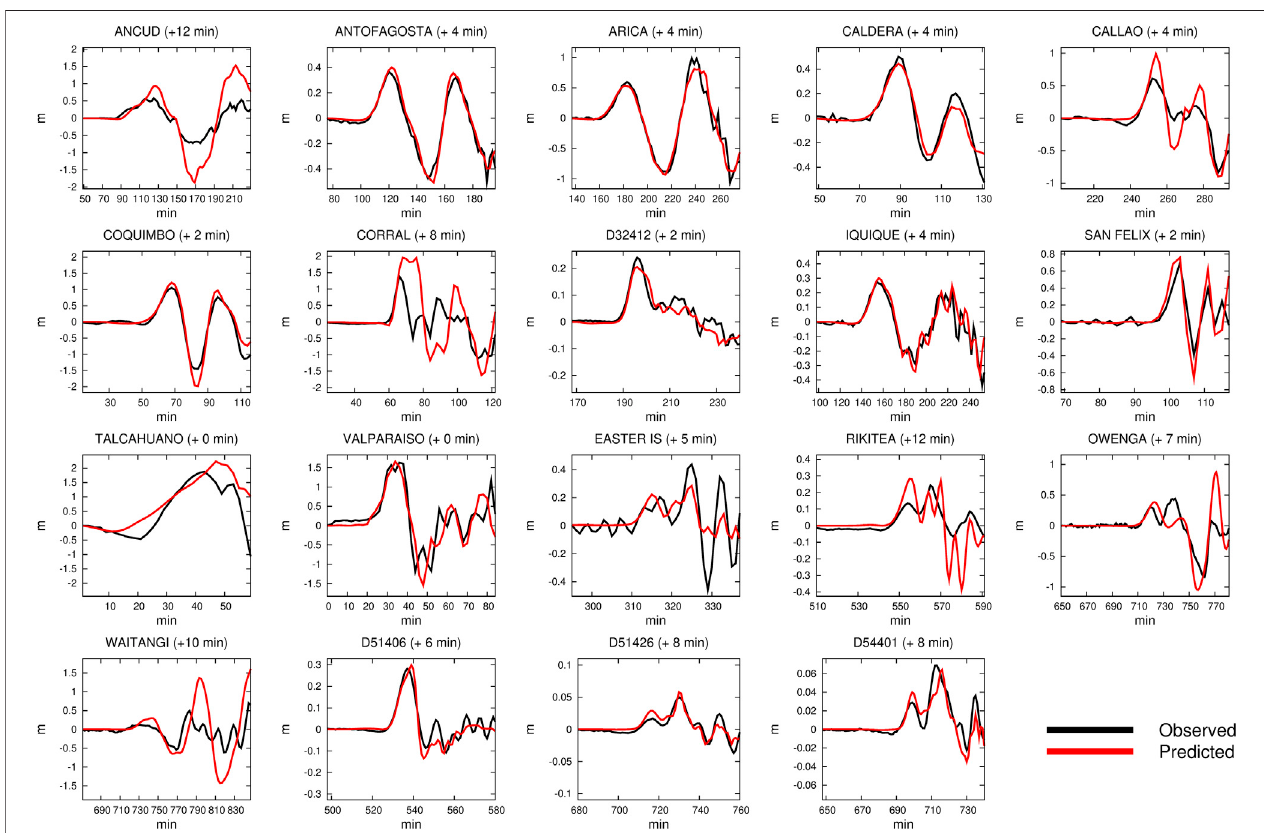
FIGURE12| Comparison betweenobserved(in black) andpredicted (inred)tsunamiwaveforms fortheslipdistribution obtainedbyjointlyinverting thesame GPS datasetused fromMoreno et al.(2012)and Yue etal.(2014),InSAR, land-leveling,andtsunami datausing OTA( Figure 11 );thetimemismatchestimated bytheOTAis indicated within